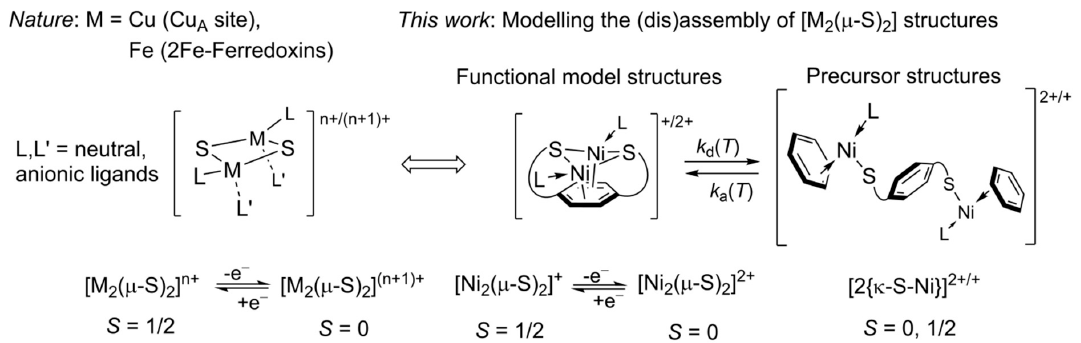
Figure 1. Comparison of geometric and electronic structures of natural bimetallic sites of the general type [M 2 ( µ -S) 2 ] with a set of four bimetallic model structures of nickel.